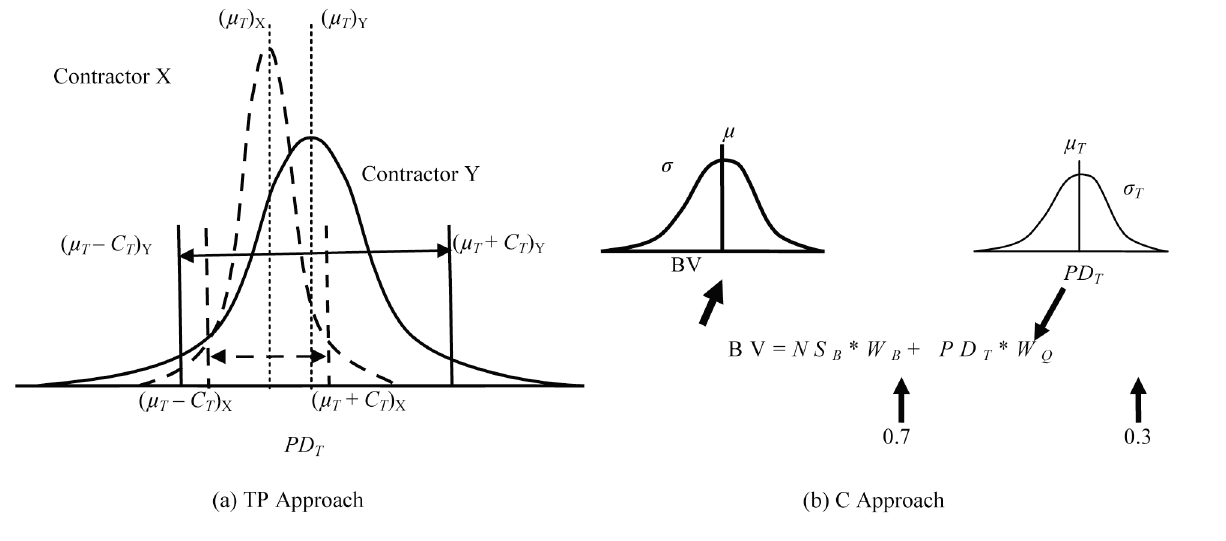
Fig. 4. Best value score